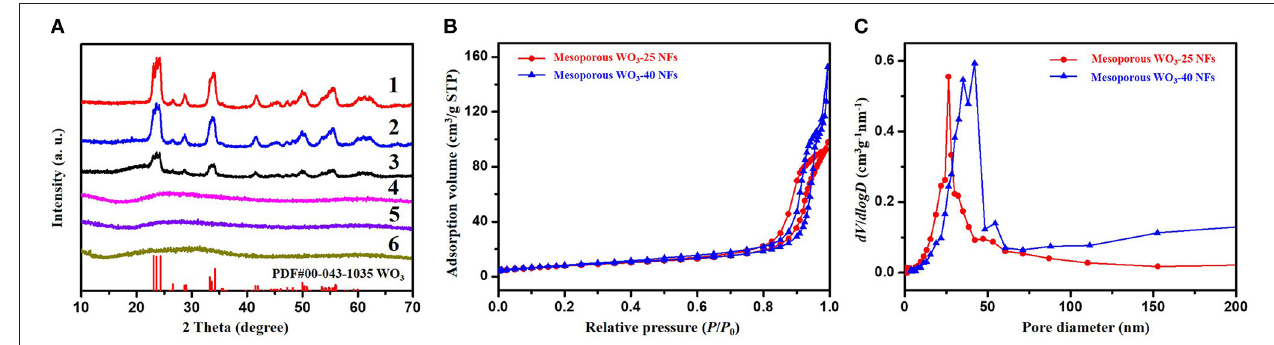
FIGURE 3 | (A) XRD patterns of (1) mesoporous WO 3 -25 NFs, (2) mesoporous WO 3 -40 NFs, (3) non-mesoporous WO 3 NFs, (4) WO 3 /carbon/SiO 2 (25nm) NFs, (5) WO 3 /carbon/SiO 2 (40nm) NFs, (6) WO 3 /carbon NFs. (B) Nitrogen-sorption isotherms and (C) pore size distribution curves of mesoporous WO 3 -25 NFs and mesoporous WO 3 -40